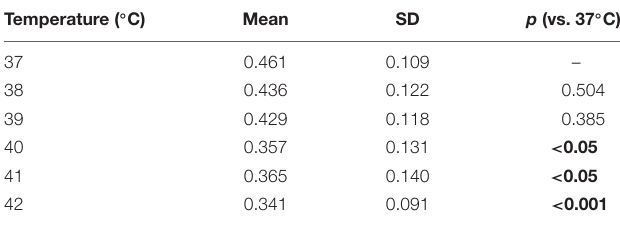
TABLE 1 | Electroencephalography (EEG) amplitude averaged across recording sessions as a function of the temperature and p -values obtained by comparing the amplitude at each temperature against that at 37 ◦ C.